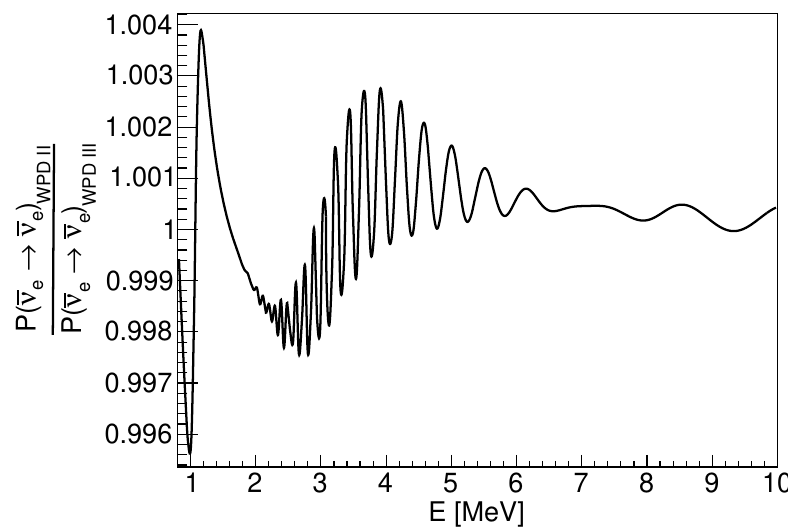
Figure 2. The ratio of the ¯ ν e survival probabilities between the WPD II and WPD III scenarios as a function of the neutrino energy. Here the oscillation parameters are taken from table 2 and the damping parameter σ rel is set to 2 . 08 × 10 − 2 , which corresponds to a 5 σ CL limit obtained from this